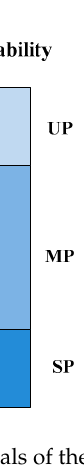
Figure 2. The critical intervals of the three phases.